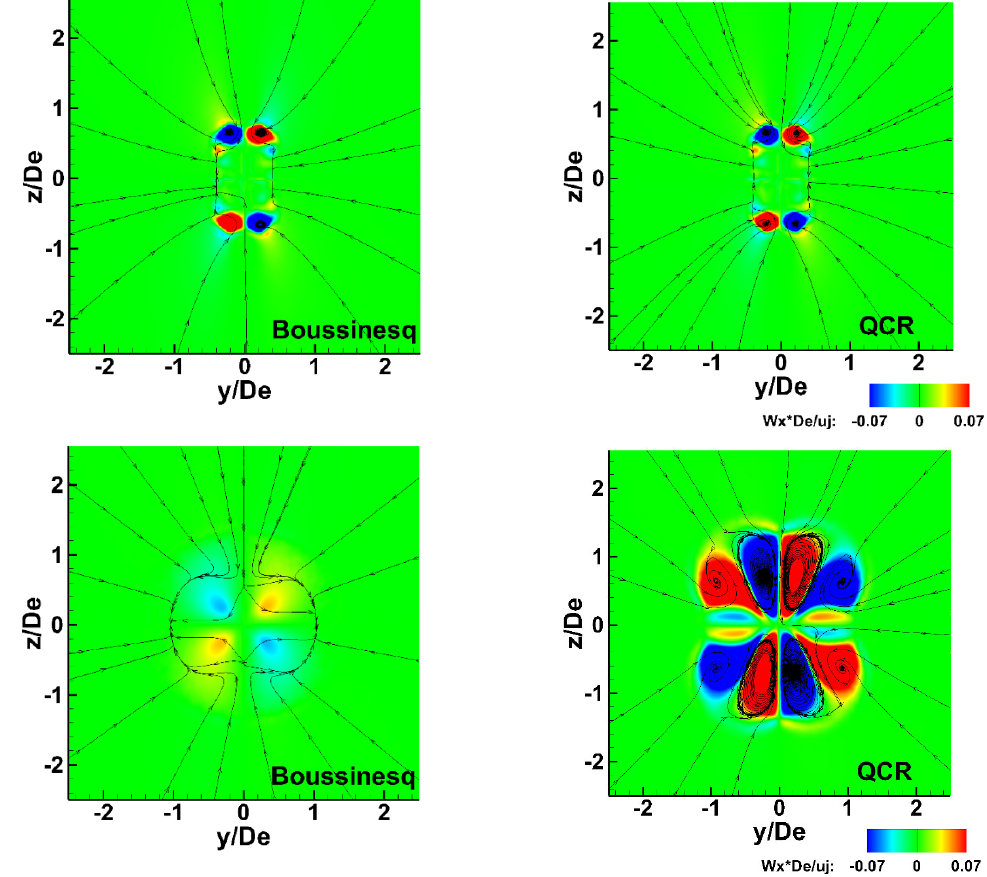
Figure 14. Streamwise vorticity contours along cross ‐ flow planes at x/De = 1 (top) and x/De = 8.9 (bottom).